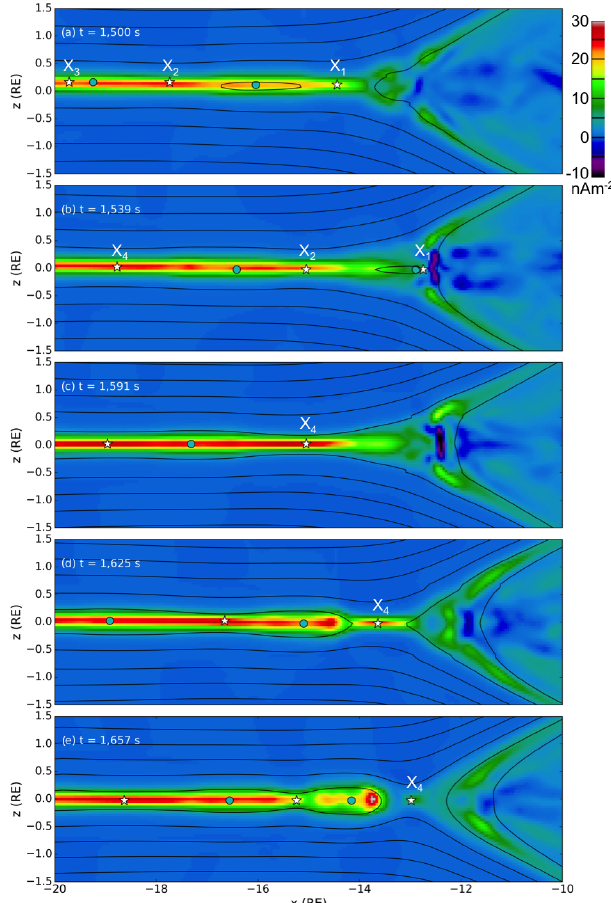
Figure 2. Zoom to the tail plasma sheet, with current density colour- coded, showing the duskward current component flowing in the tail plasma sheet in the X − Z plane. Reconnection locations are marked with white stars, while magnetic islands are cyan circles. Some re- connection locations are identified with X n , ( n = 1 ... 4), and panels (a) – (e) show their evolution in